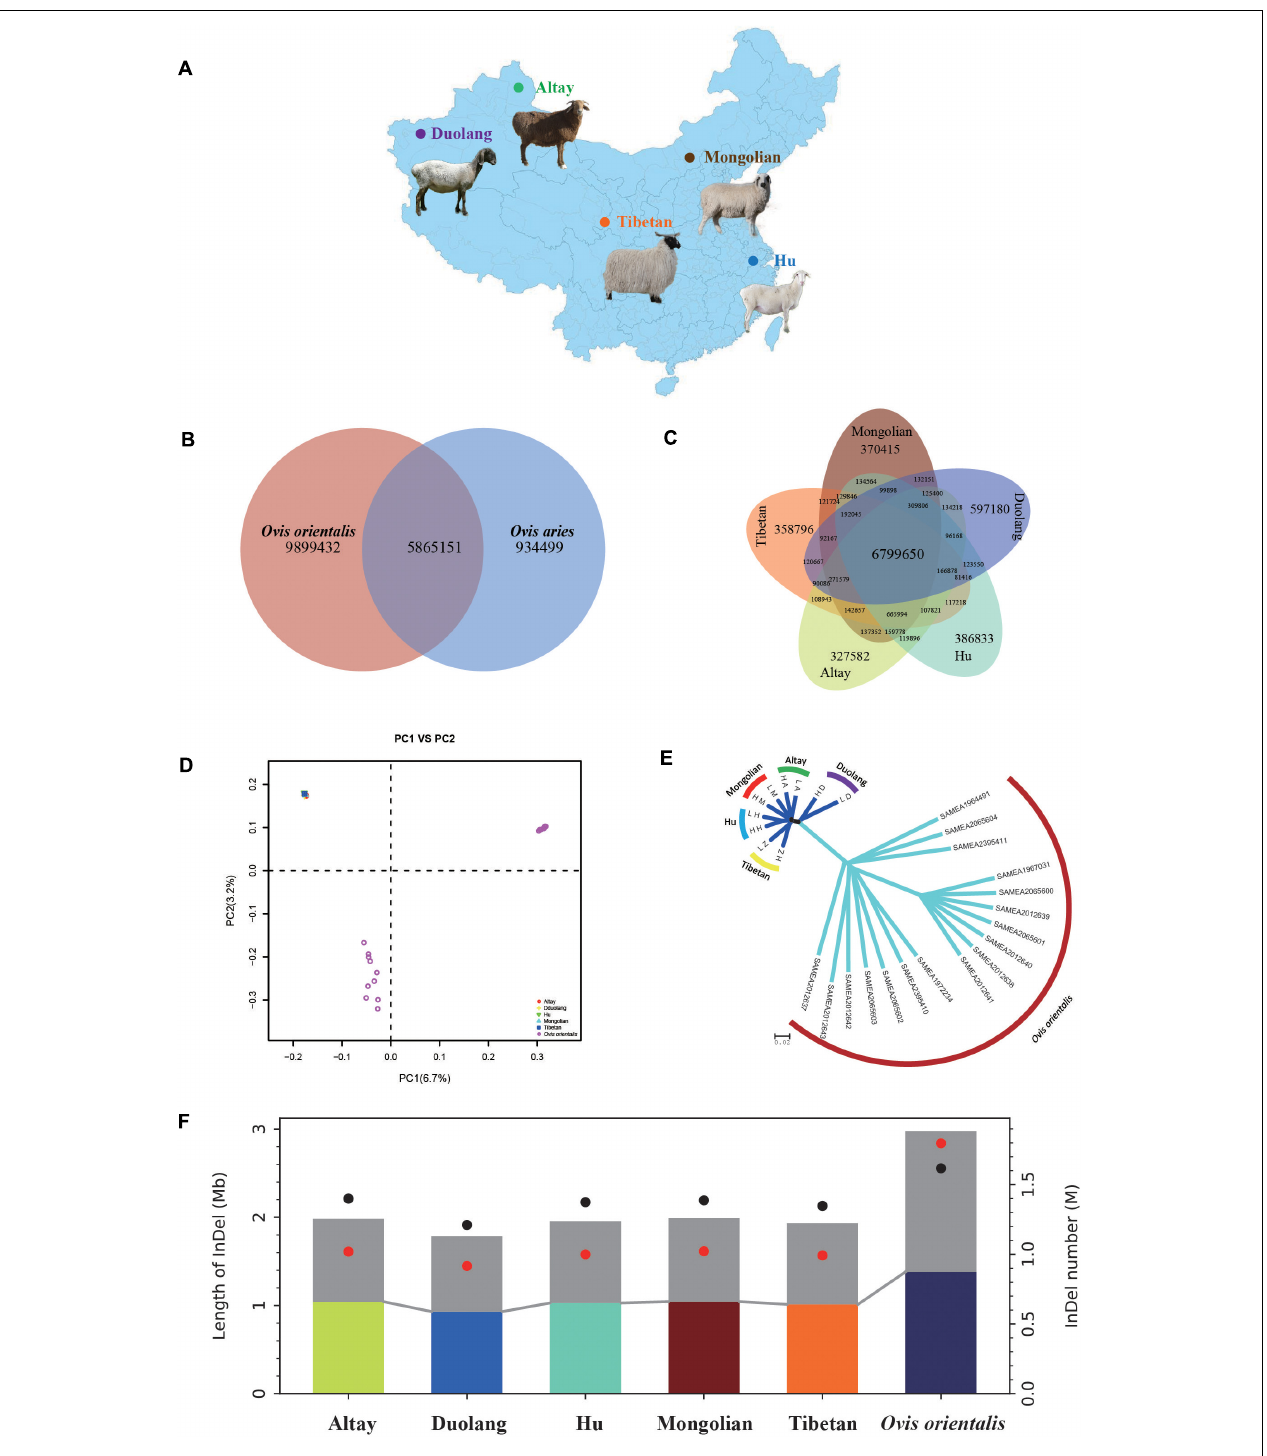
FIGURE 1 | Geographic distribution and population genetics analyses of five indigenous Chinese sheep breeds ( Ovis aries ) and Asian Mouflon ( Ovis orientalis ). (A) Geographic distribution of five indigenous Chinese sheep breeds ( n = 338 sheep). The map was generated uusing Adobe Illustrator CS6 software (https://www.adobe.com/cn/products/illustrator.html). (B) Venn diagram showing the shared single nucleotide polymorphisms (SNPs) between Ovis aries and Ovis orientalis . (C) Venn diagram showing the shared SNPs between the five indigenous Chinese sheep breeds. (D) Principal component (PC) analysis; PC 1 versus PC 2. (E) Neighbor-joining tree. (F) The length and number of indels in five indigenous Chinese sheep breeds and Ovis orientalis . Black and red dots represent the number of insertions and indels, respectively. Colored and gray pillars represent the length of insertions and indels, respectively.